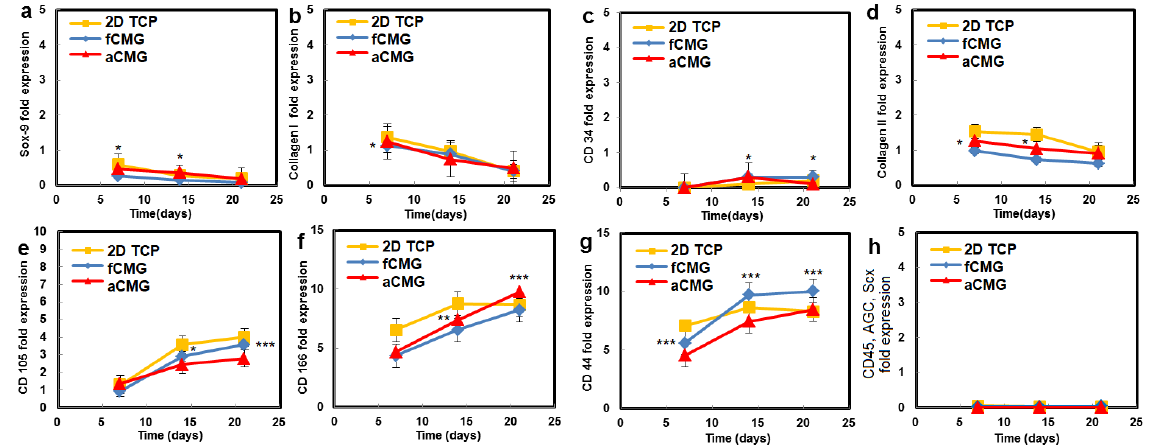
Figure 4. The mRNA expression of markers ( a ) Sox-9, ( b ) Col I, ( c ) CD34, ( d ) Col II, ( e ) CD105, ( f ) CD166, ( g ) CD44, and ( h ) CD45, AGC, Scx of hMSCs cultured on adult (red) and fetal (blue) CMGs in basal medium as a function of culture time; the control group (yellow) was hMSCs cultured on 2D tissue culture plates in basal medium. The average size of CMGs in CMG-MSCs for mRNA expression studies was 190 µm; one asterisk (*), two asterisks (**), and three asterisks (***) indicate a statistically significant difference between two experimental groups at a given time point at the levels of p < 0.05, p < 0.01, and p < 0.001, respectively.